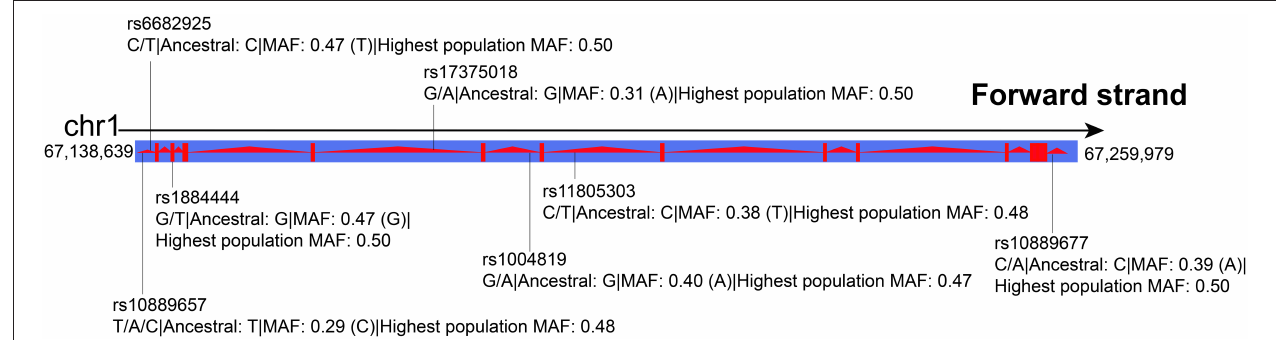
FIGURE 1 | SNPs in IL-23R . Highest population minor allele frequency: highest minor allele frequency observed in any population including 1,000 Genomes Phase 3, ESP, and genomAD.